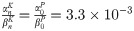
Enzyme sequestration by the substrate does not have the same effect as directly decreasing enzyme and substrate concentrations.a) The 4-site original system simulated with sufficient sequestration for monostability to occur (right) (αnKβnK=α0Pβ0P=3.3×10-3
nM−1). The steady state concentrations of PS0 and KS4 due to sequestration are determined (left). b) The same system is simulated with lowering the total substrate and enzyme concentrations by those amounts.